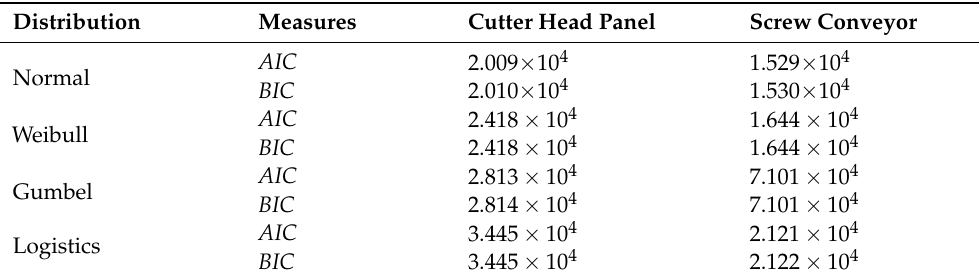
Table 11. AIC and BIC values for the cutter head panel and screw conveyor under different distribu- tions. The bold fonts generally indicate the lowest values in the